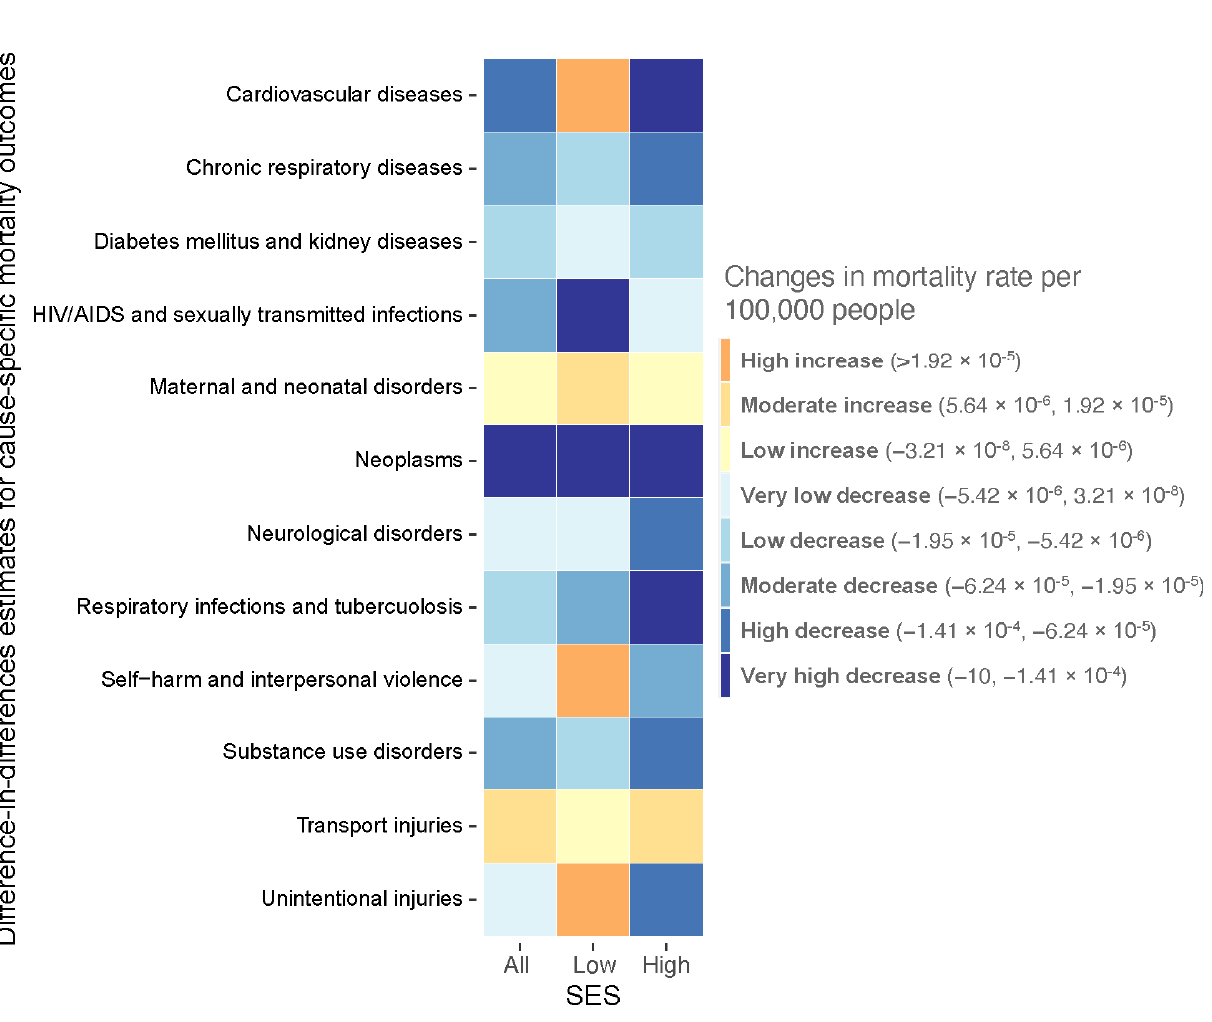
Figure 2. Summary of the direction and relative magnitude of difference-in-differences estimates on cause-specific mortality rates by SES (All CTs, Low SES CTs, and High SES CTs), Metro Vancouver, British Columbia, 1990–2016. Difference-in-differences estimates were categorised into tertiles for increases [high increase (>1.92 × 10 − 5 per 100,000 people), moderate increase (low to high range of tertile: 5.64 × 10 − 6 , 1.92 × 10 − 5 ), and low increase ( − 3.21 × 10 − 8 , 5.64 × 10 − 6 )] and quintiles for decreases [very-low decrease (low to high range of quintile: − 5.42 × 10 − 6 , 3.21 × 10 − 8 ), low decrease ( − 1.95 × 10 − 5 , − 5.42 × 10 − 6 ), moderate decrease ( − 6.24 × 10 − 5 , − 1.95 × 10 − 5 ), high decrease ( − 1.41 × 10 − 4 , − 6.24 × 10 − 5 ), and very-high decrease ( − 10, − 1.41 × 10 − 4